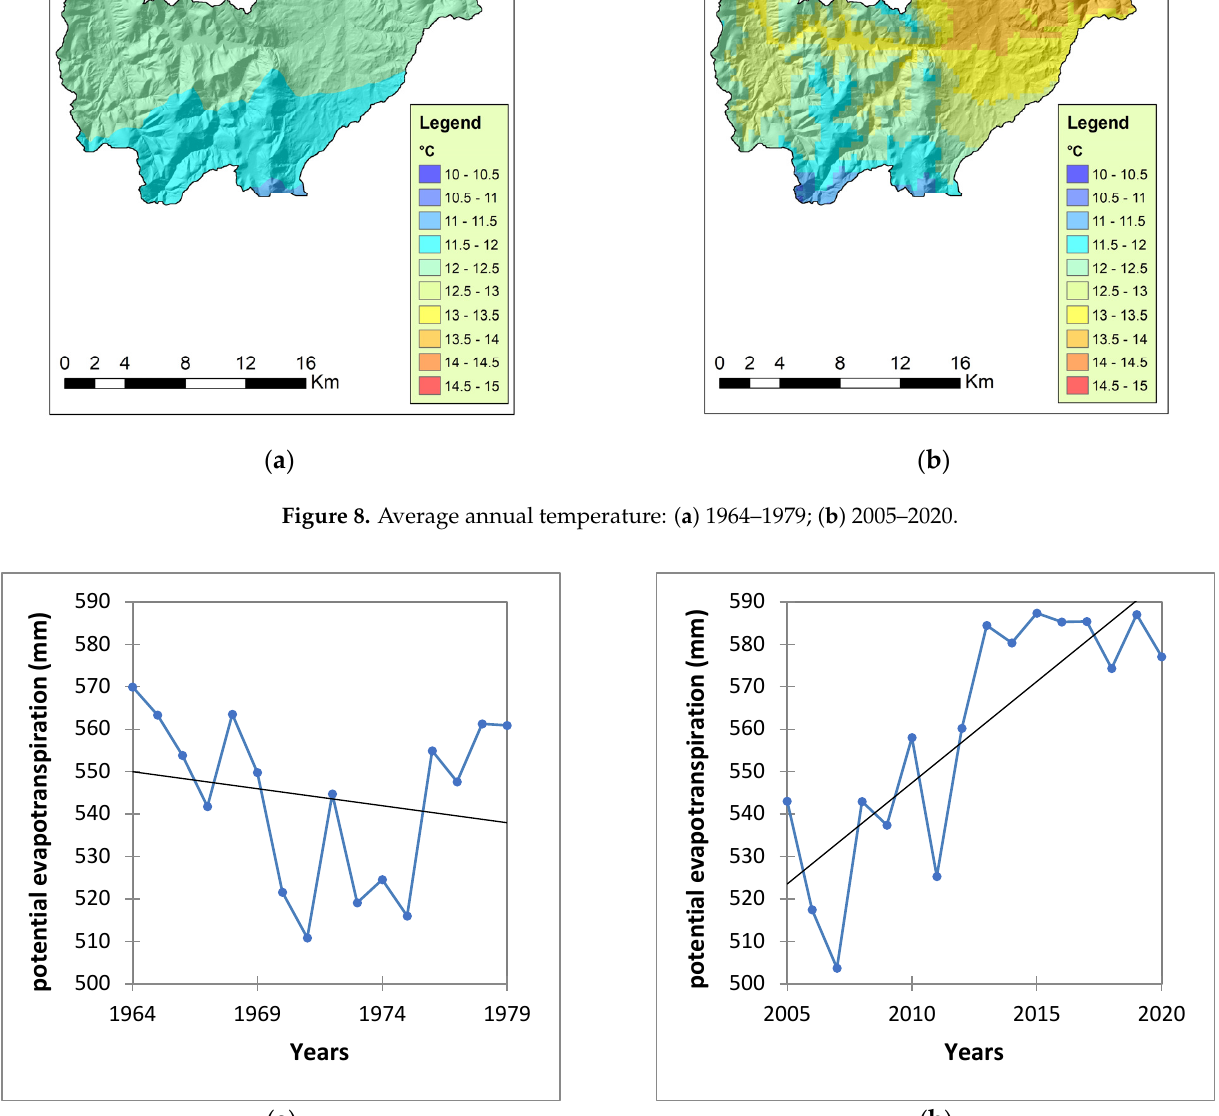
( b ) Figure 10. Streamflow and trend line in black colour: ( a ) 1964–1979; ( b ) 2005–2020.